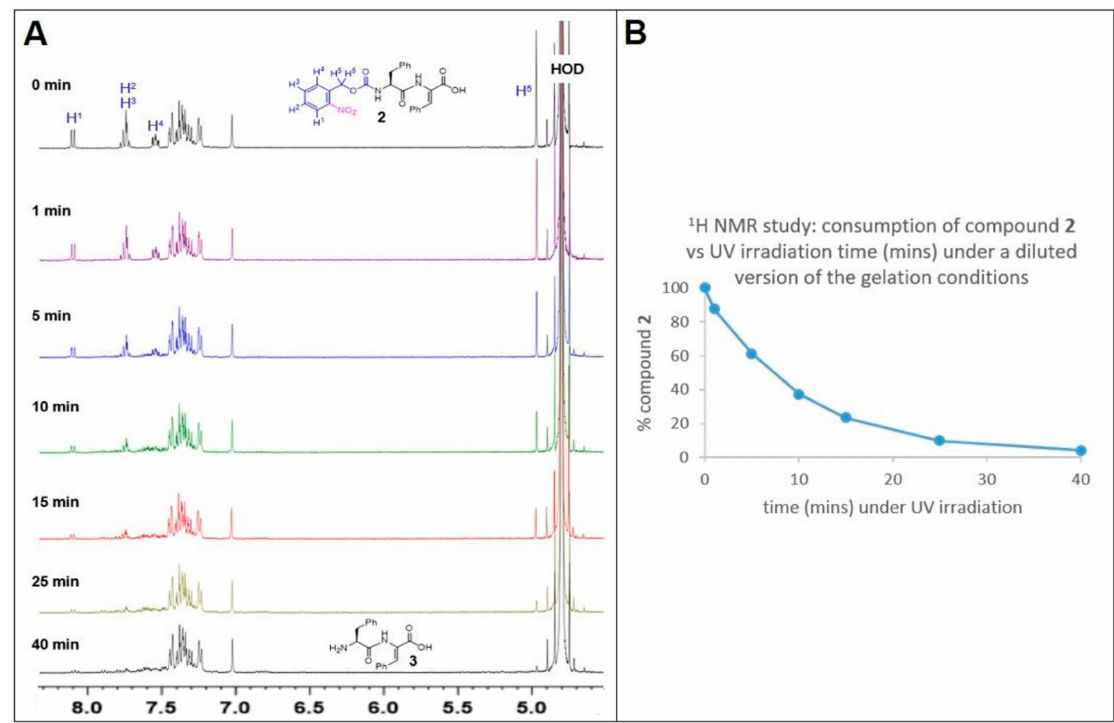
Figure 4. Panel ( A ): 1 H NMR spectra showing the removal of the carboxy-2-nitrobenzyl (CNB) group, to form 3 from 2 , at different time-points following irradiation with UV light (360 nm), after performing a diluted version the gelation in an NMR tube. Panel ( B ): The percentage of CNB group removal at each time-point was calculated by integration, and the percentage conversion was plotted against the time irradiated with 360 nm UV light